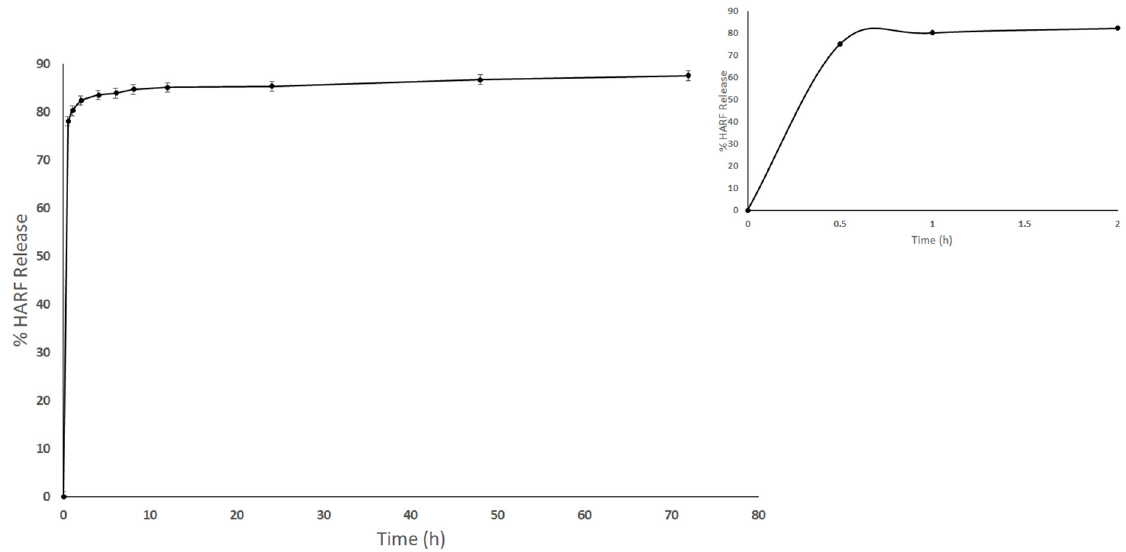
Figure 4. Time-dependent release profiles of HARF from the optimal H/CS/PLGA NPs, at 37 ◦ C, into phosphate buffer media (the first 2 h are marked in the insert).